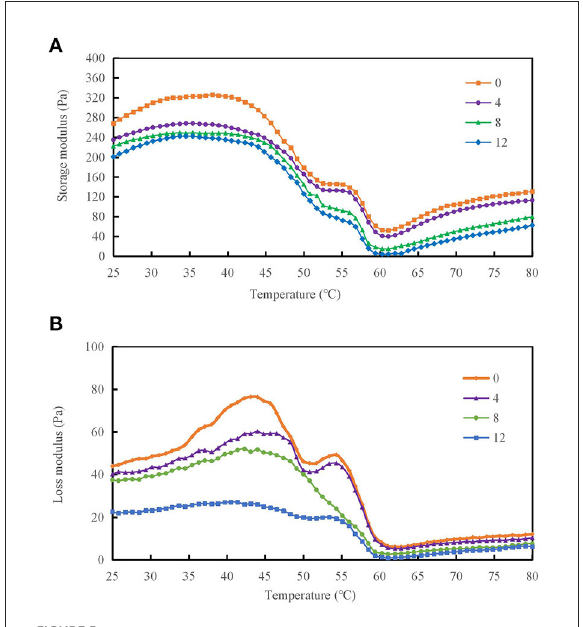
FIGURE5 Variation in storage modulus (A) and loss modulus (B) of duck myofibrillar protein (DMPs) solution pretreated with various hydroxyl radical levels (H 2 O 2 concentrations: 0, 4, 8, 12 mmol/L).